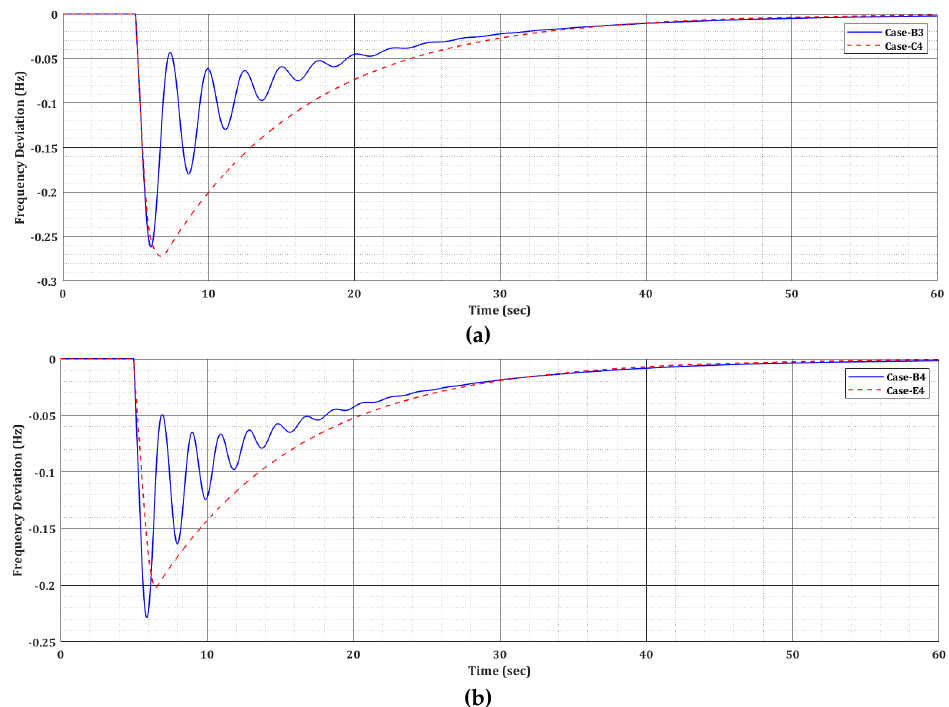
Figure 10. Comparison of various configurations ( a ) comparison of a 2-machine system case (B3) with a single machine system augmented with responsive loads (C4); ( b ) comparison of a 3-machine system case (B4) with a single machine system augmented with ESS (E4).